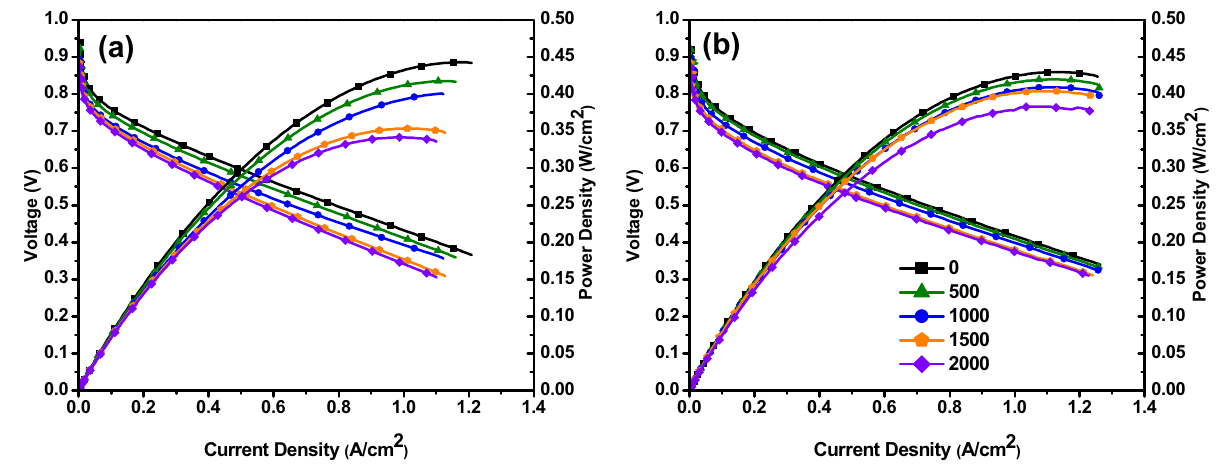
Figure 4. Polarization curves of ( a ) DLC1 and ( b ) DLC2 presented for every 500 cycles.